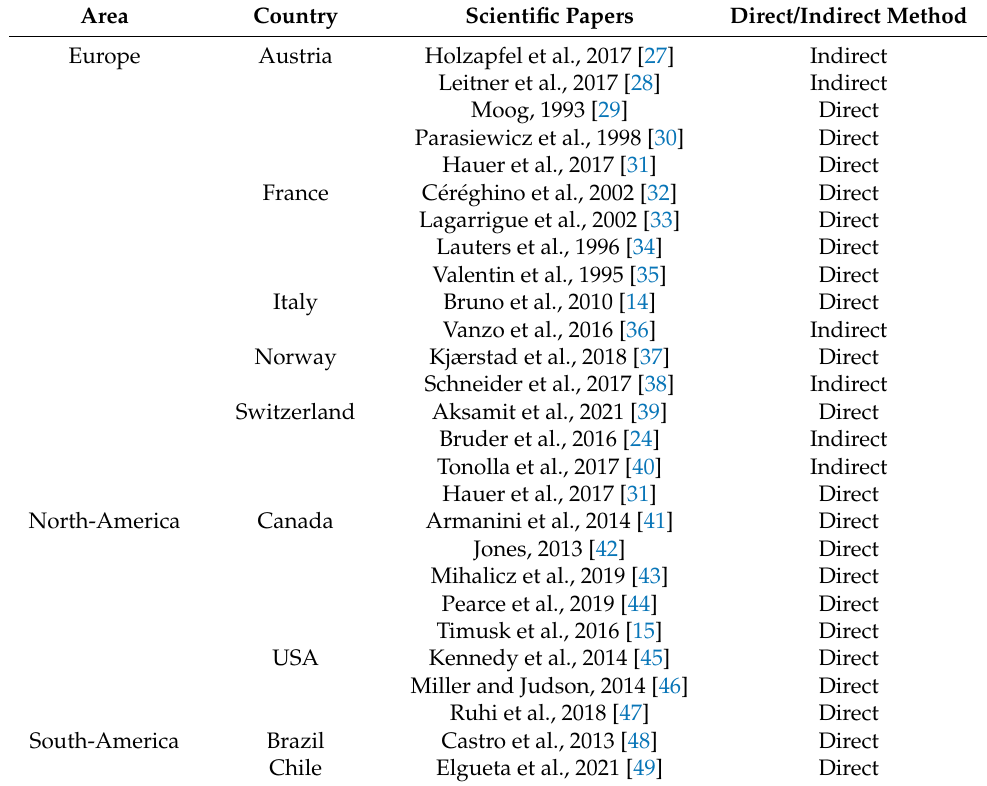
Table 1. List of papers regarding monitoring of the effects of hydropeaking on benthic macroinverte- brates, subdivided by country and